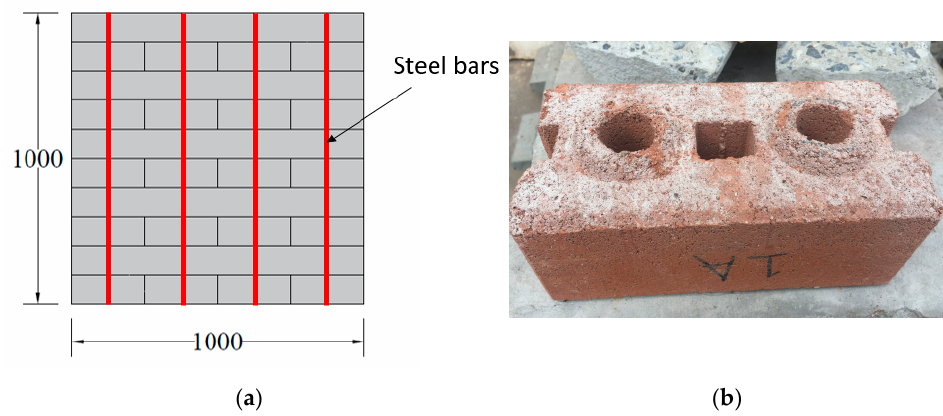
Figure 2. Typical details of the CCIB masonry wall (units, mm): ( a ) Wall details; ( b ) CCI brick.